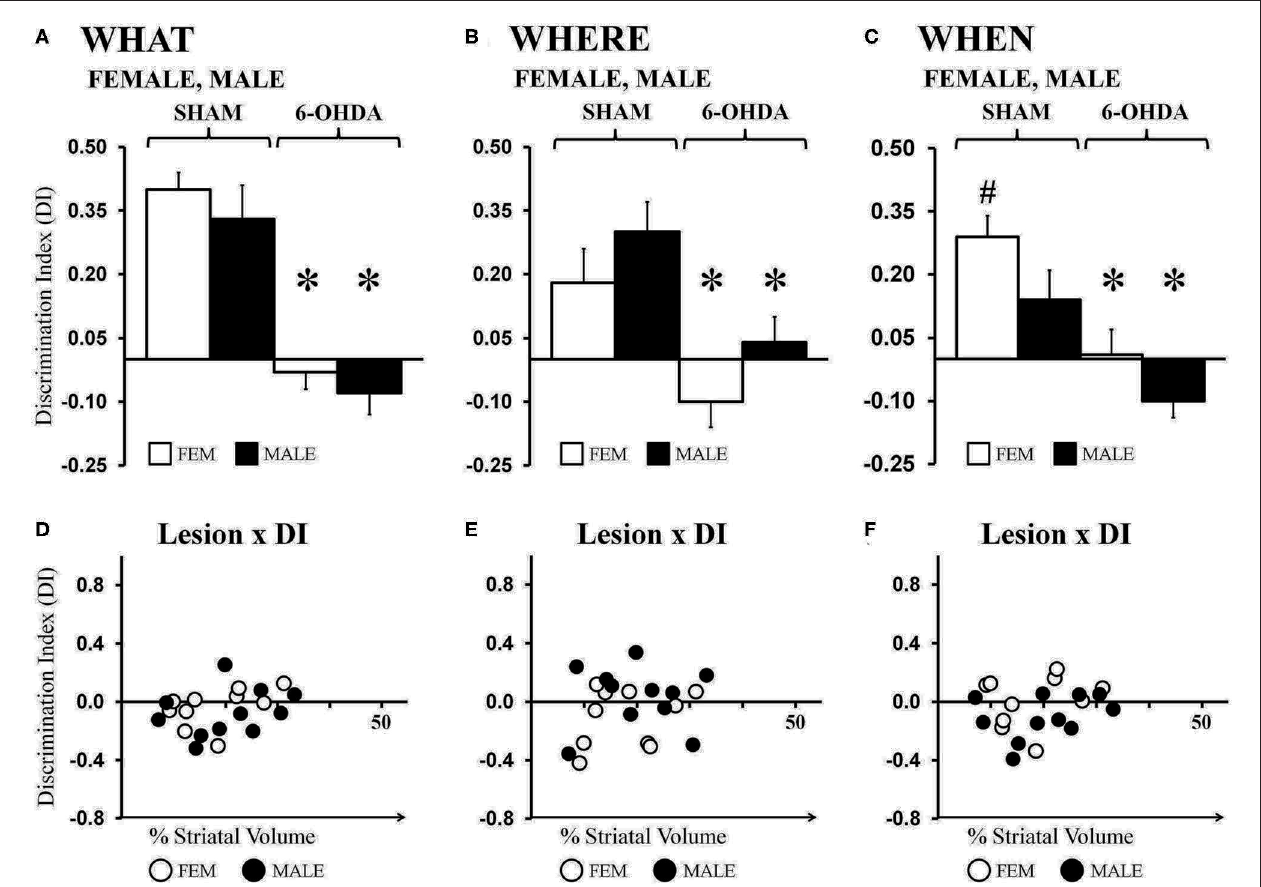
FIGURE 4 | Bar graphs showing average “What” (A) , “Where” (B) , and “When” (C) discrimination indices (DIs) calculated from object exploration in Test Trials for gonadally intact sham-operated (SHAM) and 6-hydroxydopamine lesioned (6-OHDA) female (FEM, white) and male (MALE, black) rats. DIs for all domains were robust for FEM SHAM and MALE SHAM; trends for MALE over FEM advantage for “Where,” and FEM over MALE advantage for “When” were also seen. In contrast, DIs for all domains were impaired in FEM 6-OHDA and MALE 6-OHDA groups. Results from post-hoc comparisons are shown as follows: significant differences in DIs between the SHAM and 6-OHDA lesioned female and male rats (*); near significant differences in “When” discrimination between the SHAM-lesioned FEM and MALE groups ( p = 0.053, #). Scatter plots of “What” (D) , “Where” (E) , and “When” (F) DIs expressed as functions of the size (percent of total striatal volume) of 6-OHDA lesions for individual gonadally intact FEM (white circles) and MALE (black circles) rats show no significant or consistent relationships between the two.